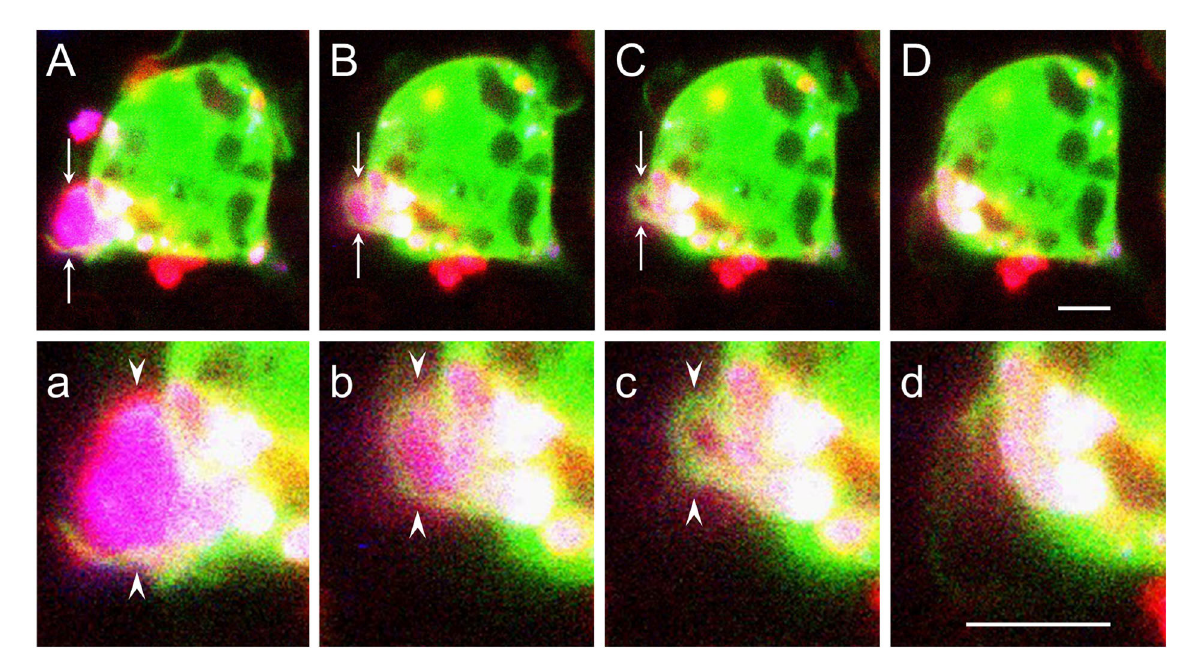
FIGURE1 Filopodia/lamellipodia extend and engulf myelin debris and then retract and internalize the debris. [ (A–D) and (a–d) ] Time-lapse cinematography images of successive steps during live ongoing phagocytosis of a myelin debris particle by a wild-type macrophage. (A–D) Arrows mark filopodia/lamellipodia-like structures (green and/or red) that form a phagocytic cup that engulfs a myelin particle (purple), and (a–d) arrowheads mark enlarged images of the phagocytic cup. First (A,a) , filopodia/lamellipodia engulf myelin. Then, [ (B–D) and (b–d) ], filopodia/lamellipodia retract, pulling the debris into the phagocyte. Timing after the onset of phagocytosis in (A,a) , (B,b) , (C,c) , and (D,d) are, respectively, 3.5, 6.5, 7.5, and 8.5min. Live ongoing phagocytosis was monitored continuously by confocal fluorescence microscopy at a single plane of focus. The macrophage cytoplasm is visualized by Ca + 2 indicator Fura-4 (green), myelin by DiIc18 (blue), and macrophage cell membrane by RH237 (red). The fluorophore RH237 was also incorporated into myelin that turned purple (blue + red). Each image is a composite of three sequential scans taken during ongoing phagocytosis, one for each fluorophore, resulting in cytoplasmic Ca + 2 indicator Fura-4 (green) obscuring the RH237 (red) labeled thin plasma membrane apart from in (A,a) where the red labeled plasma membrane is clearly seen. Bars: 5 µ m for (A–D) in (D) and 5 µ m for (a–d) in (d) . Figure modified after Hadas et al.